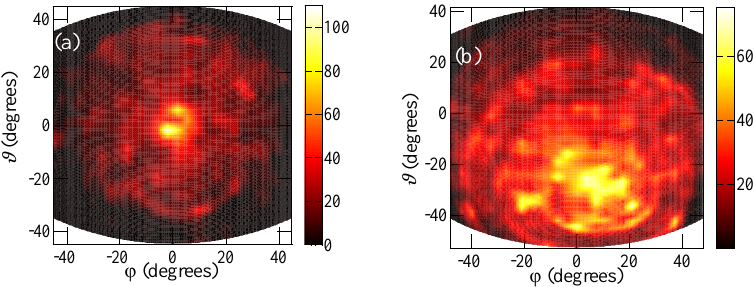
Figure 6. Emission spectra of type A ( a , b ) and type B ( c , d ) quasi-crystal lasers collected via an Fourier transform infrared spectrometer in rapid scan acquisition mode at 10 K while driving the QCLs with a 1% duty cycle. Panel (a) refers to a type A resonator with a = 29.9 µm, panel (b) to a type A resonator with a = 32.5 µm, panel (c) to a type B resonator with a = 28.8 µm and panel (d) to a type B resonator with a = 30.0 µm; ( e ) Q-factor of the computed optical modes as a function of the radiation frequency for a seven-fold (type A) resonator with r = 8.0 µm and a = 29.9 µm; ( f ) Q-factor of the computed optical modes as a function of the radiation frequency for a seven-fold (type B) quasi-crystal resonator with r = 7.5 µm, a = 30.0 µm. Green vertical lines indicate the QCL gain bandwidth.